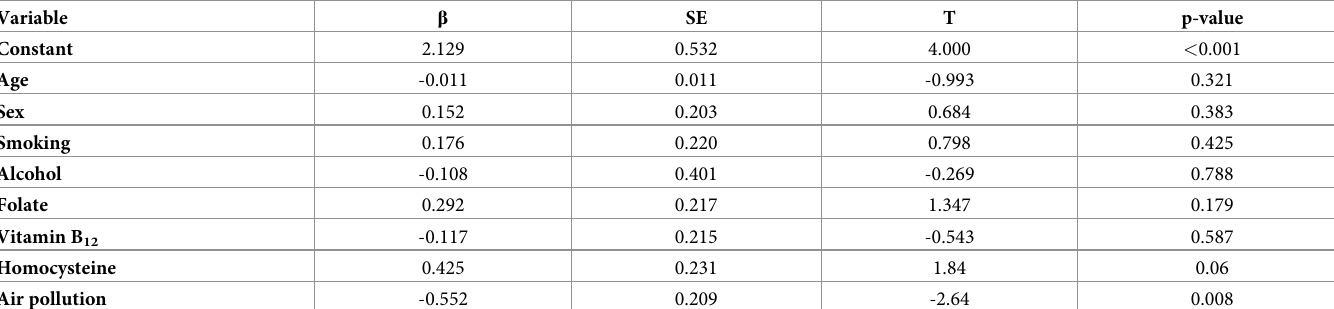
Table 3. Stepwise multiple linear regression analysis for the effect of independent variables on global methylation.